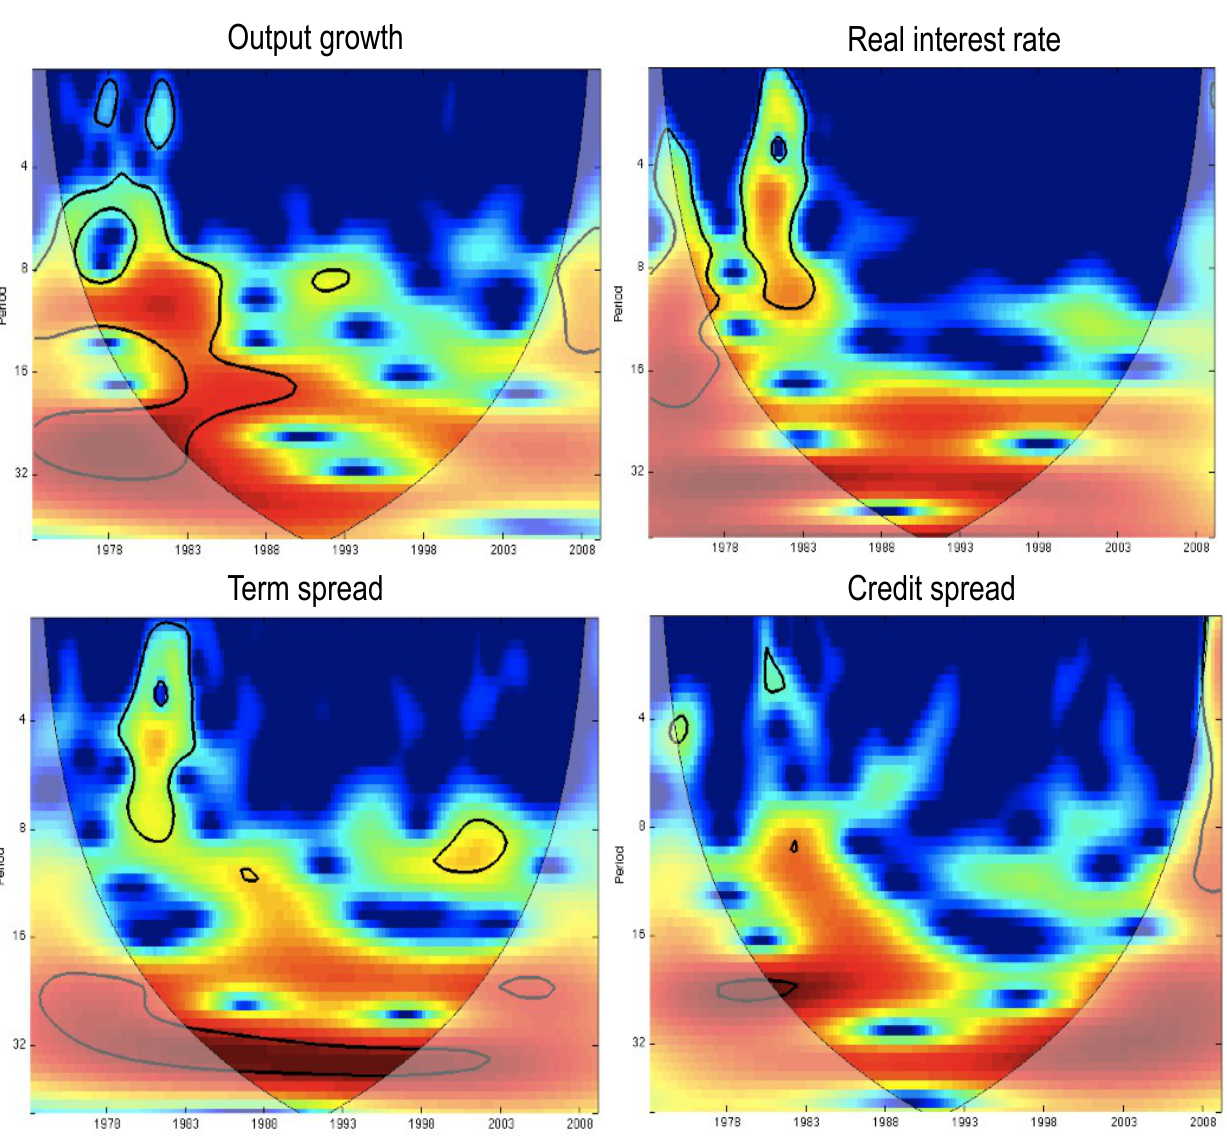
Figure 2. CWT plot for real output, real interest rate, term spread and credit spread (from top to bottomt). The color code for power ranges from blue (low power) to red (high power) with significant regions associated with warmer colors (red, orange and bright green). A black contour line testing the wavelet power 5% significance level against a white noise null is displayed as is the cone of influence, represented by a shaded area corresponding to the region affected by edge